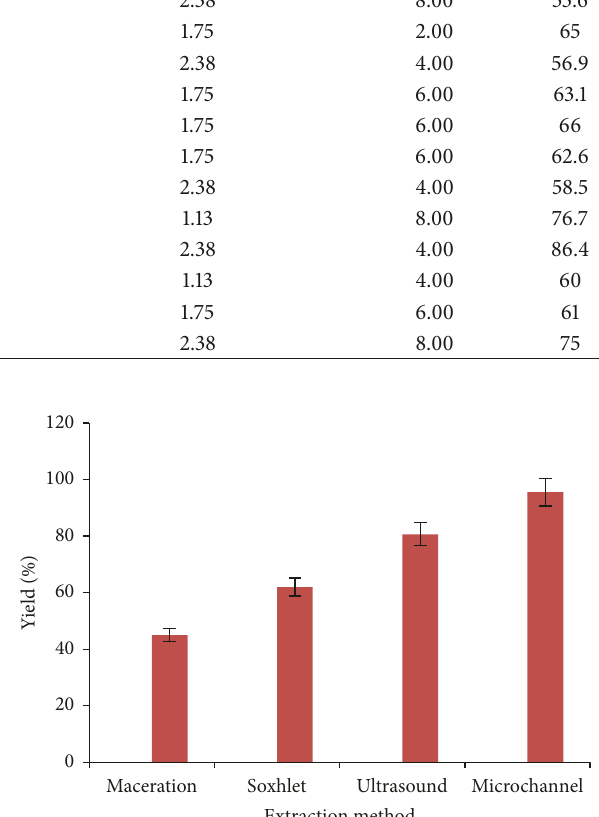
Figure 3: The correlation between the experimentally obtained values of extraction yield of oleuropein versus the calculated values using the model equation. Figure 4: Comparison of methods of oleuropein extraction from